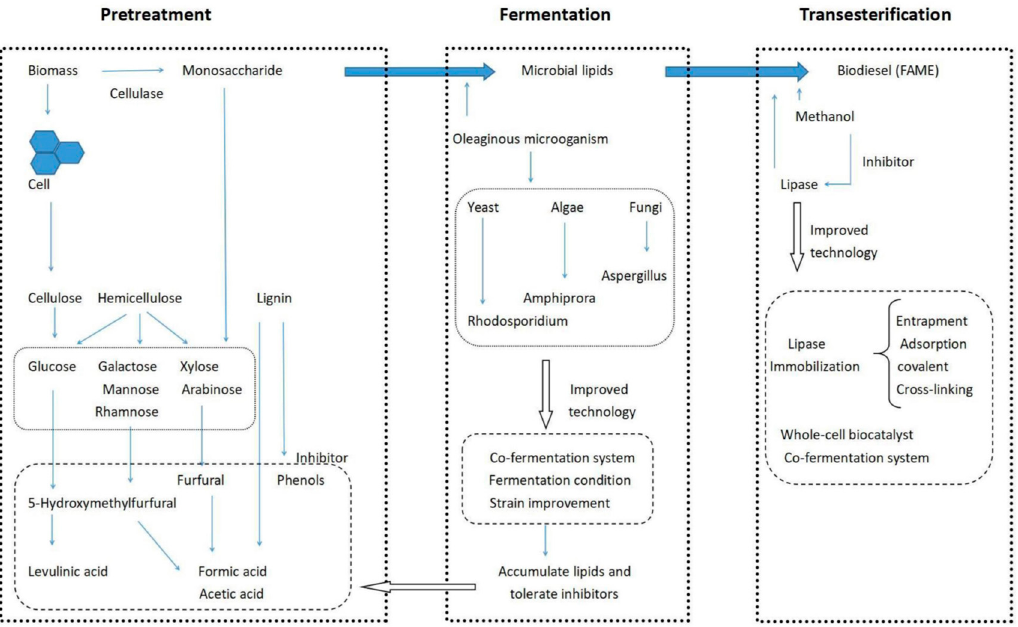
Figure 12. The Production process of using microorganisms to produce biodiesel [162].